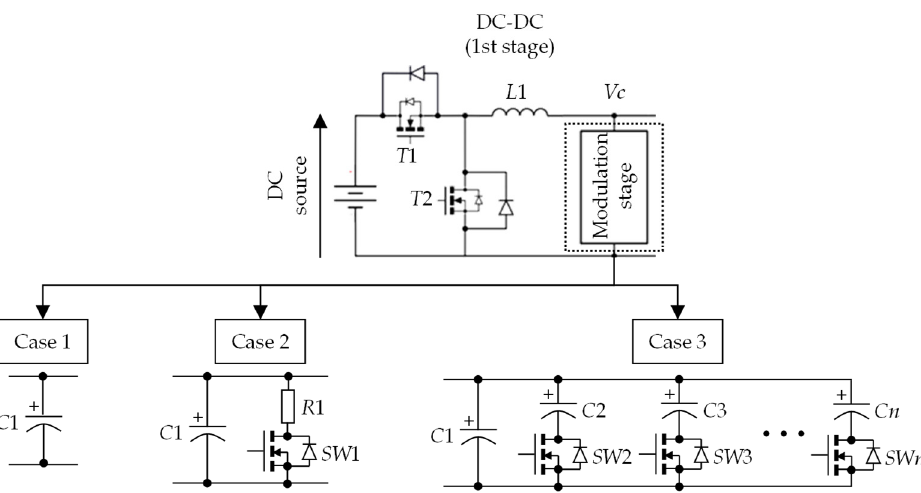
Figure 5. Solutions to modulate the output voltage of the DC–DC stage.